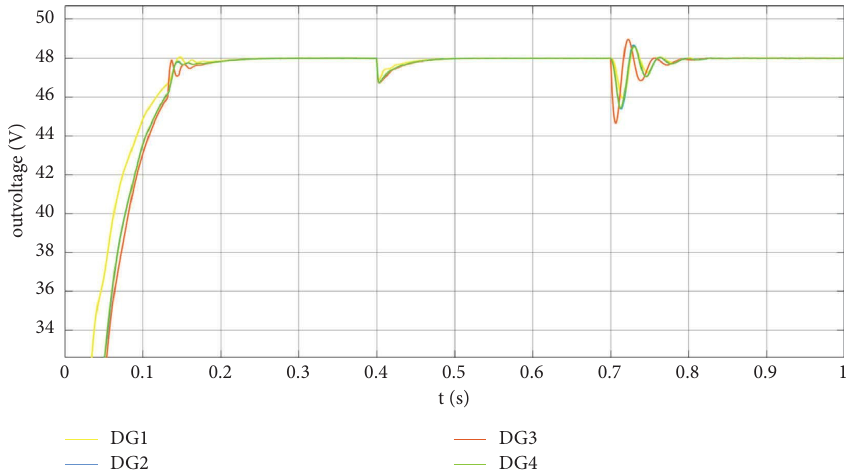
Figure 14: Output voltage with the scheme in [16].